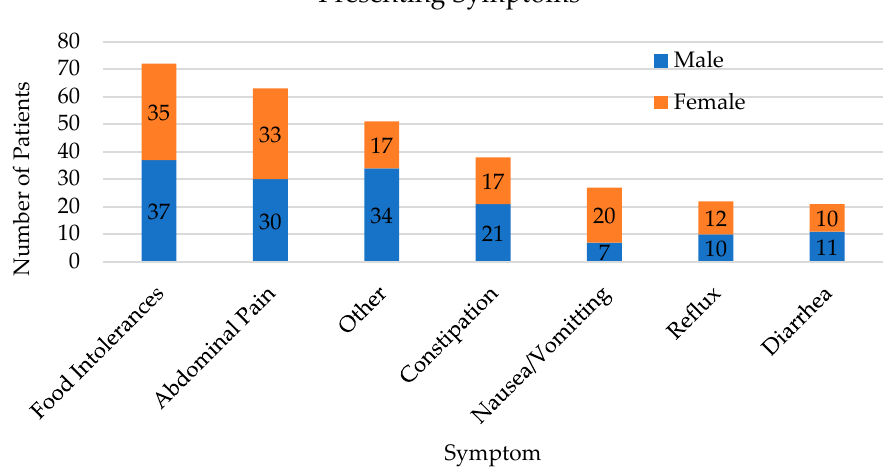
Figure 1. Presenting